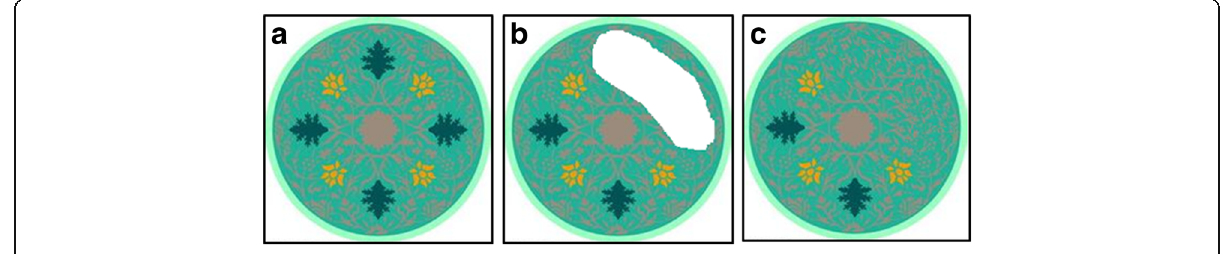
Fig. 11 a Original image; b The damaged image of ( a ); c Repaired result by exemplar-based image inpainting